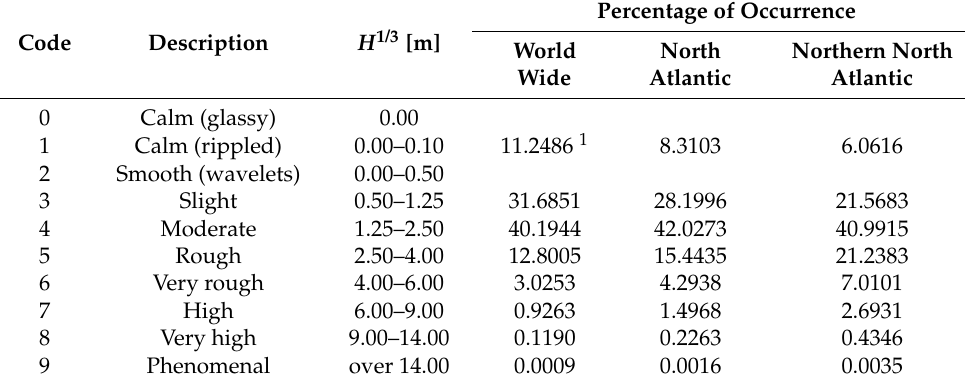
Table 1. Sea state codes